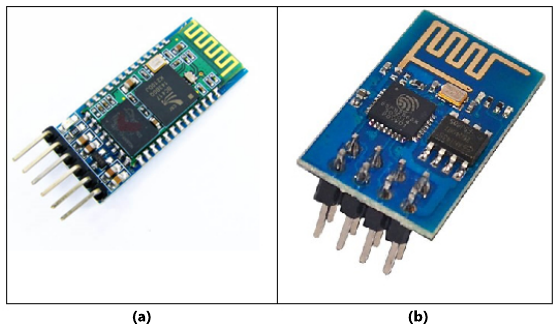
Fig. 3 (a) Bluetooth module HC-05 and (b) ESP8266 pin